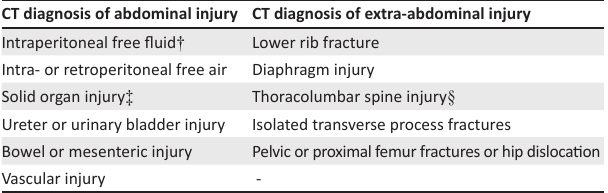
TABLE 1: Criteria defining a computed tomography diagnosis of abdominal injury and/or extra-abdominal injury. CT diagnosis of abdominal injury CT diagnosis of extra-abdominal